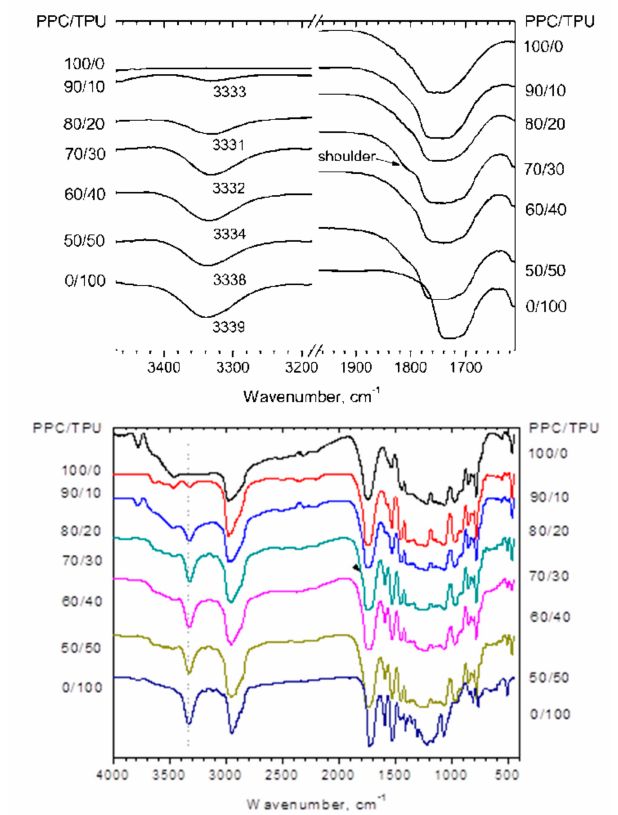
Figure 1. FTIR spectra of neat PPC, neat TPU and PPC/TPU blends.